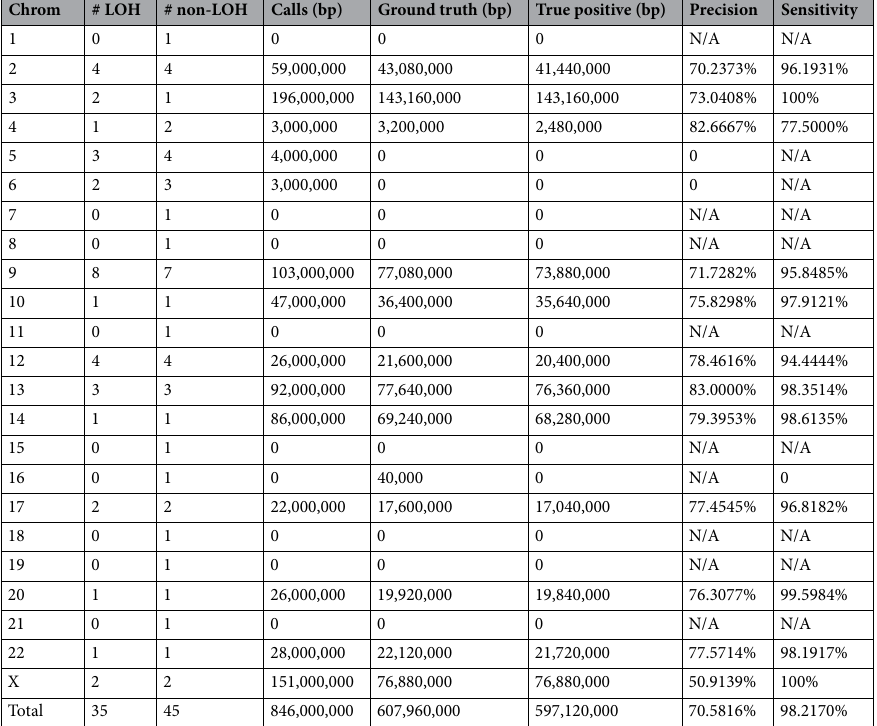
Table 2. Performance of LOH detection of HiCancer on K562 genome. Numbers in boldface highlight the best completeness and accuracy. “Chrom” is the abbreviation of “Chromosome”; “Calls”, “Ground truth” and “True positive” represent the total length of called LOH regions, total length of LOH regions in “ground truth” and their overlapped length respectively; “# LOH” and “# non-LOH” represent the numbers of continuous LOH and non-LOH regions